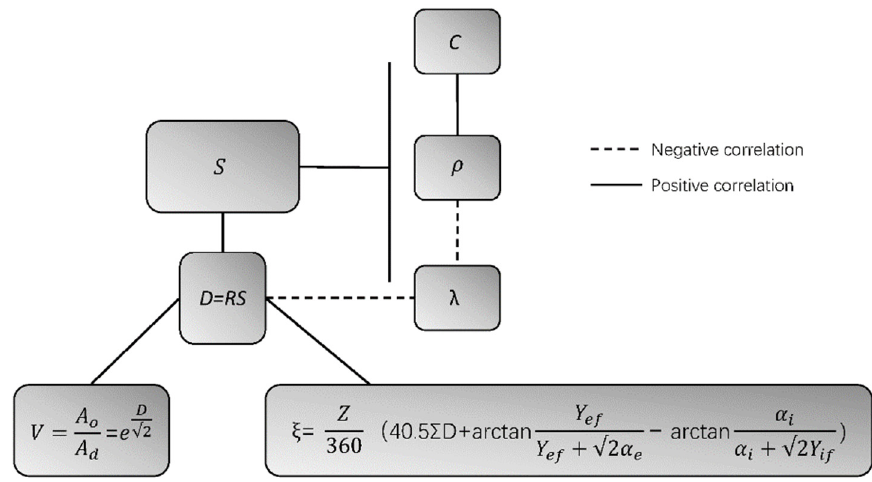
Figure 6. Relationships among the parameters of thermal storage performance.